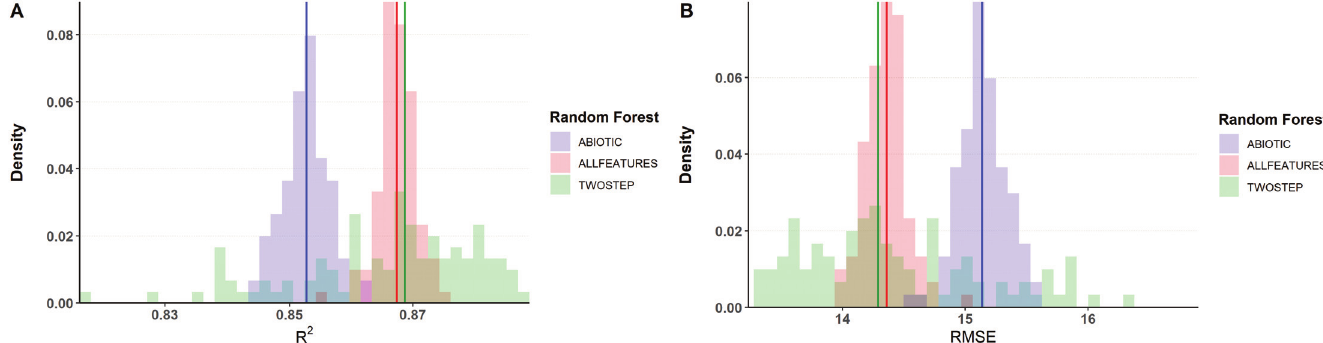
Fig 2. Prediction errors with a two-step Random Forest Regressor. A: Relative Squared Error distributions for 100 random choices of training/testing sets, vertical lines set at median values. B: Root Mean Square Error distributions for the same collection of predictors.